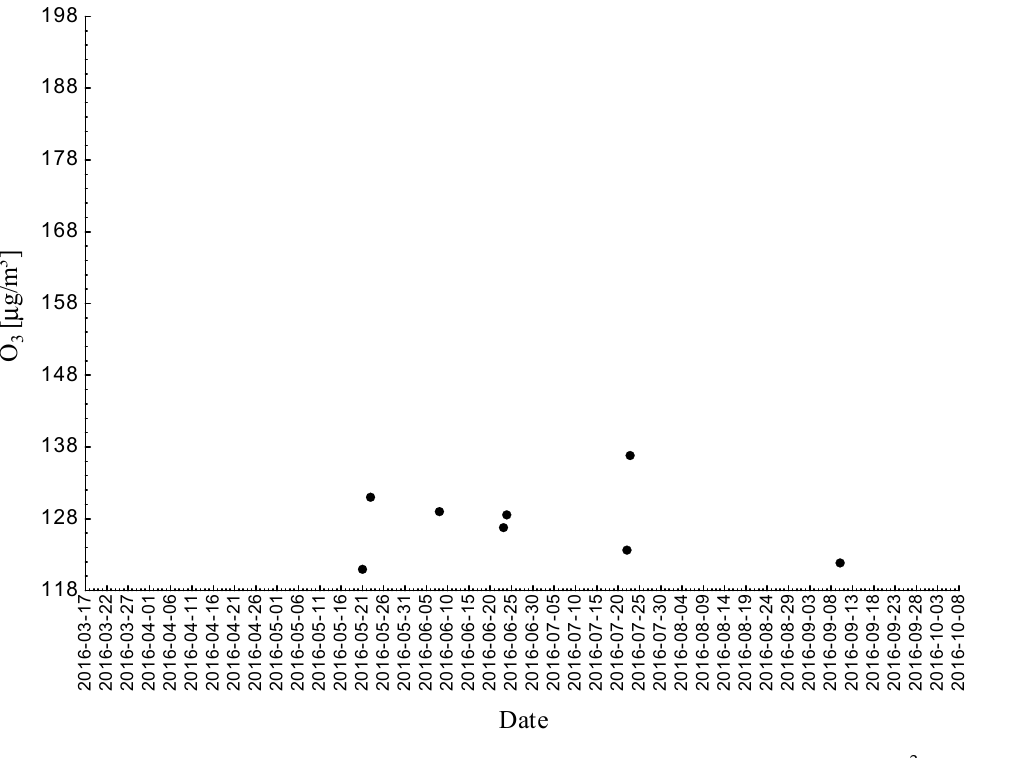
Figure 3. Maximum daily 8-h mean ozone concentration not less (equal to or more than) than 120.4 µg/m 3 registered at the measurement station in Bielsko-Biała (SL15BB) in 2016.